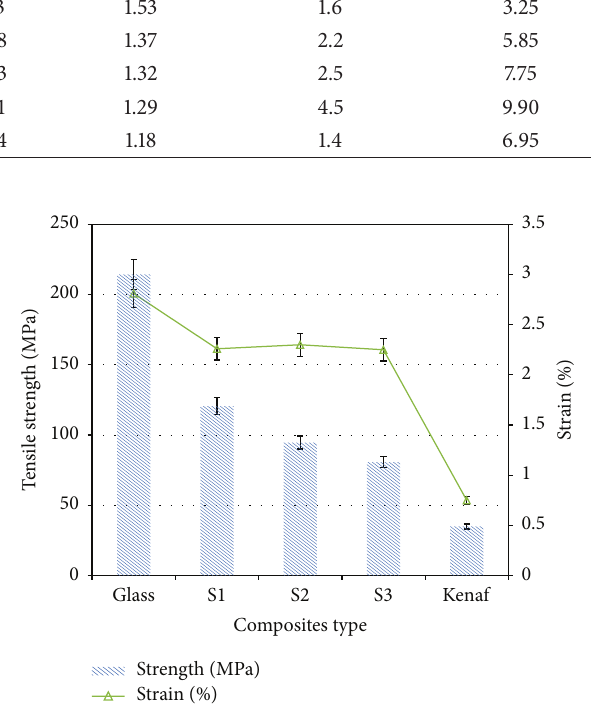
Figure 2: Tensile strength and strain of